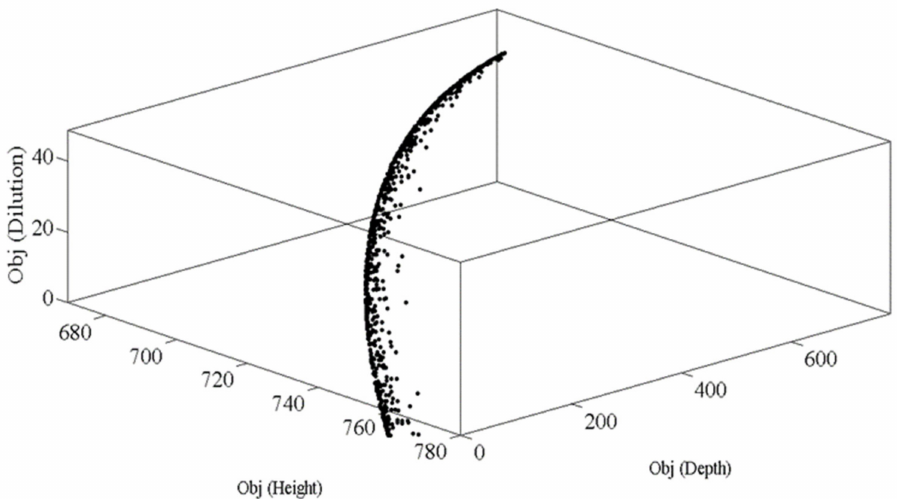
Figure 16. 3D Pareto frontier of the three objective functions including depth, dilution, and height of clads, with a feed rate of 15 g/min and with 300 ◦ C pre-heating.